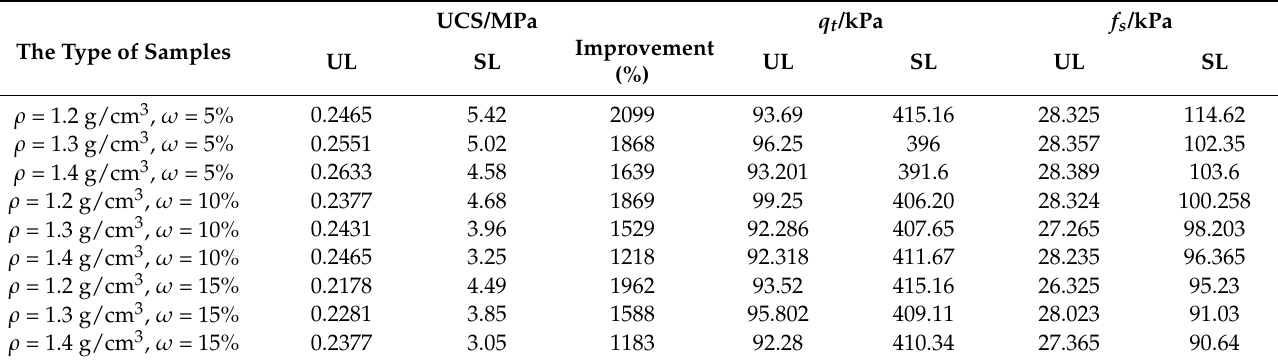
Table 5. Comparison of Mechanical